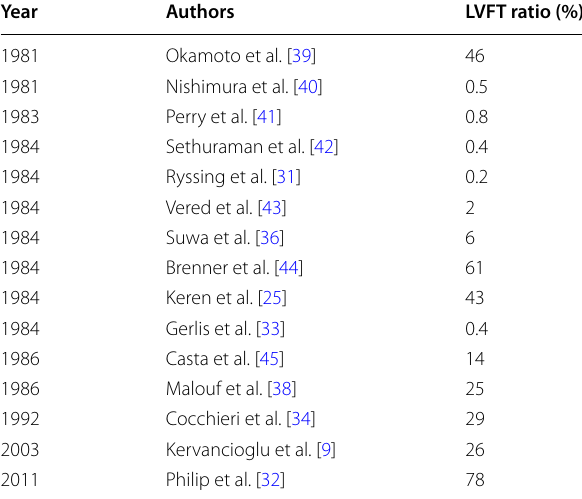
Table 3 The ratios of the left ventricular false tendon in the literature are detected only by two-dimensional transthoracic echocardiography